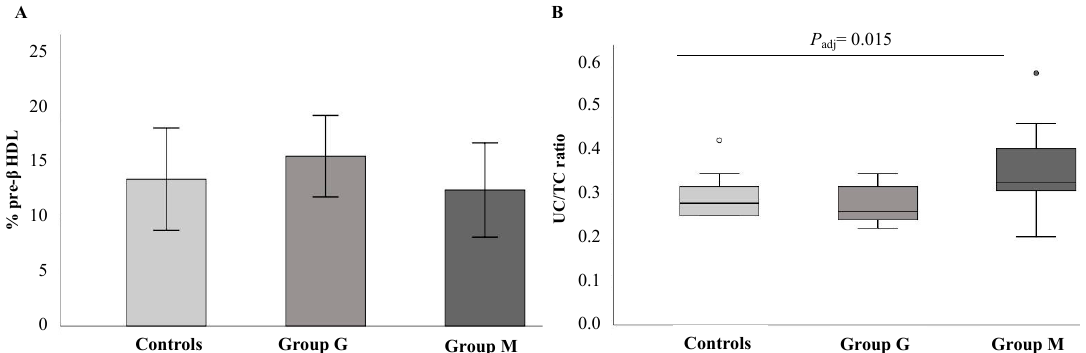
Figure 4. Comparison of percentage of pre- β HDL and UC / TC ratio between study groups. ( A ) shows pre- β HDL concentrations between study groups expressed as mean ± SE; ( B ) the box plot shows the ratio between unesterified cholesterol per total cholesterol (UC / TC ratio) expressed as median and IQR. P adj = 0.015 adjusted for ApoAI levels and HFF%. Group M, metabolic NAFLD group; Group G, genetic NAFLD group.